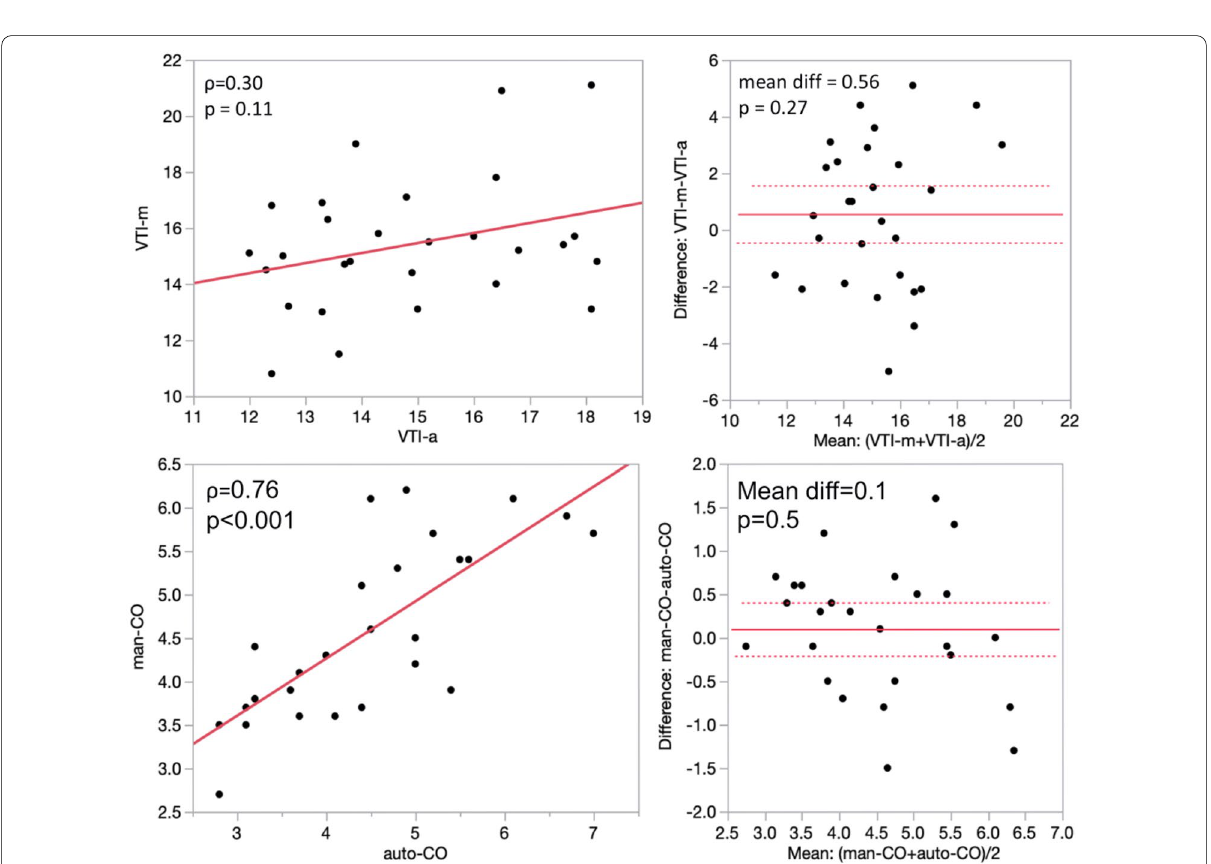
Fig. 2 Comparative analysis of trainee‑obtained manual measurements (VTI mnl‑train and CO mnl‑train ) and automated measurements (VTI auto and CO auto ). A Correlation between VTI mnl‑train and VTI auto , B Bland–Altman agreement analysis between VTI mnl‑train and VTI auto , C correlation between CO mnl‑train and CO auto , D Bland–Altman agreement analysis between CO mnl‑train and CO